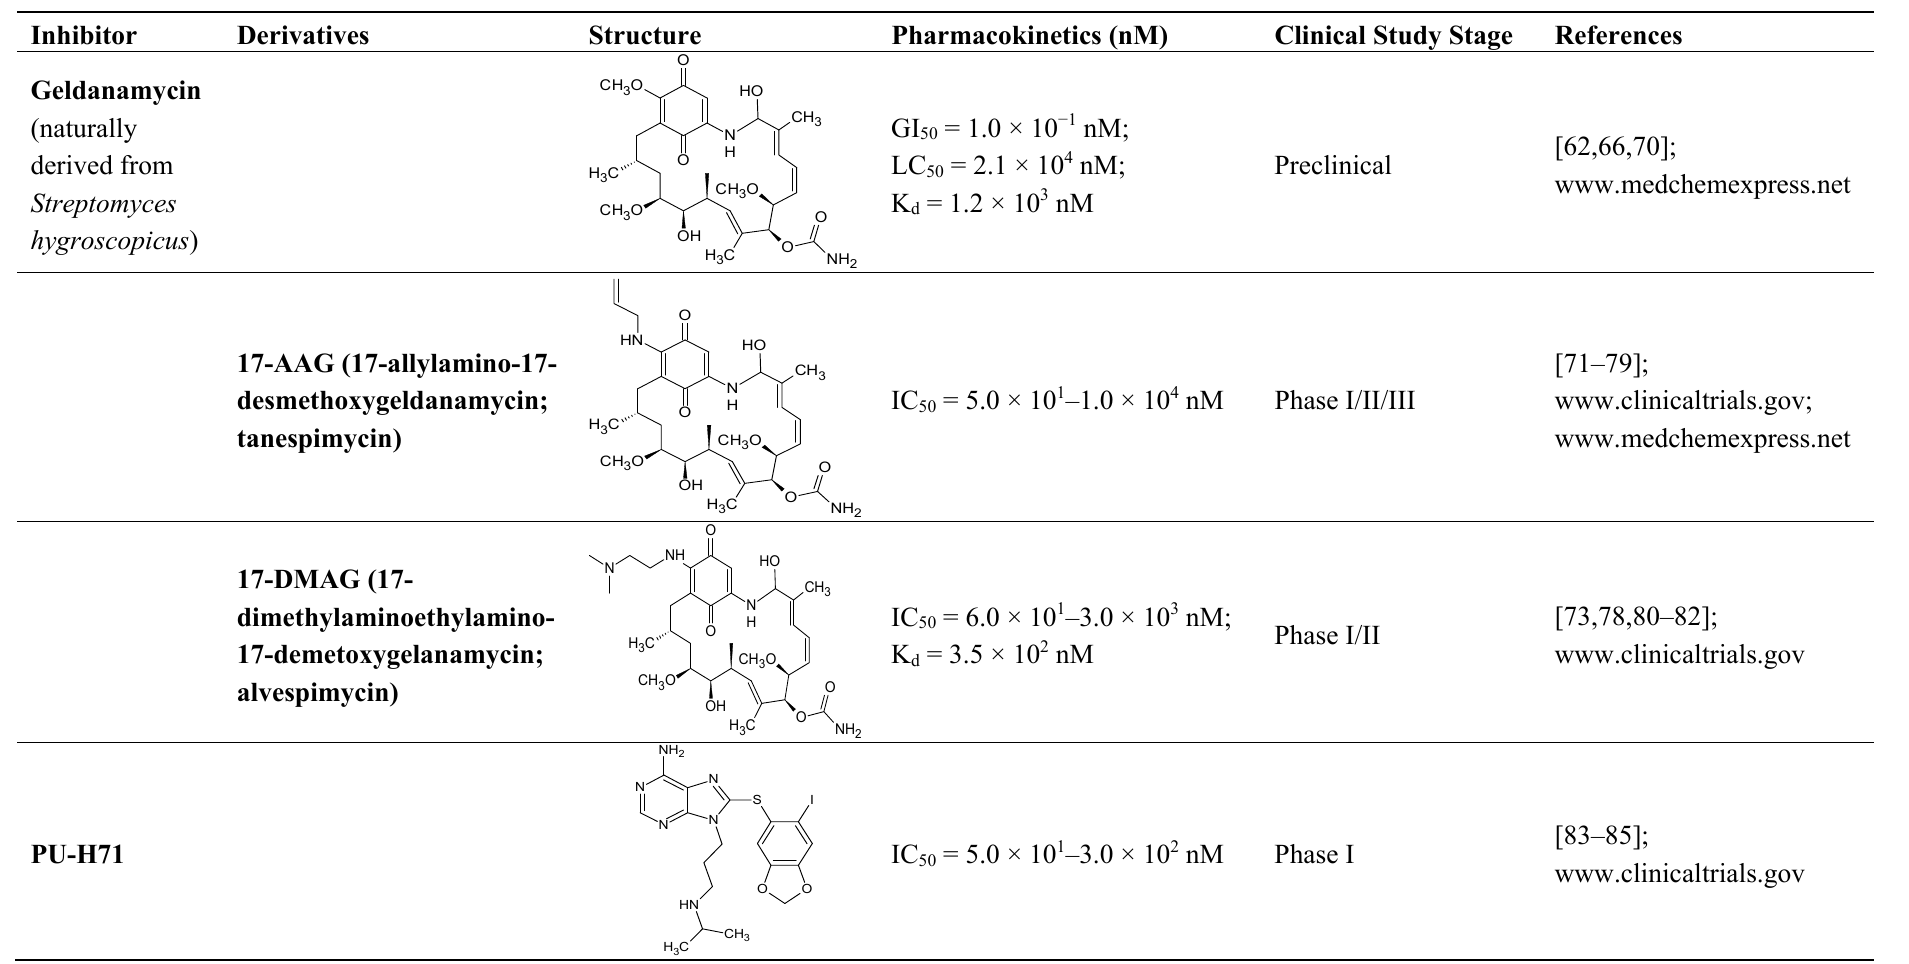
Table 1. Heat shock protein 90 (Hsp90) inhibitor affecting the DNA